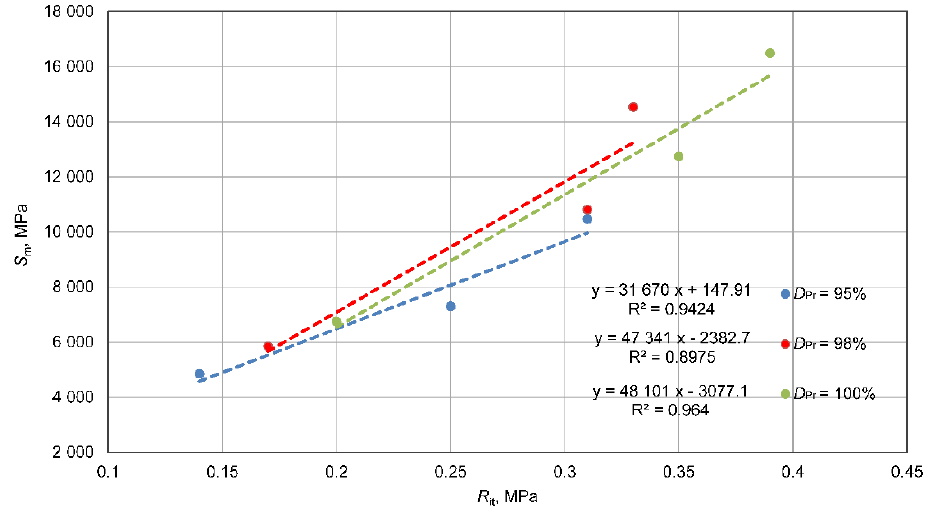
Figure 16. Relationships between indirect tensile strength, 𝑅 𝑖𝑡 , and dynamic stiffness modulus, 𝑆 𝑚 .